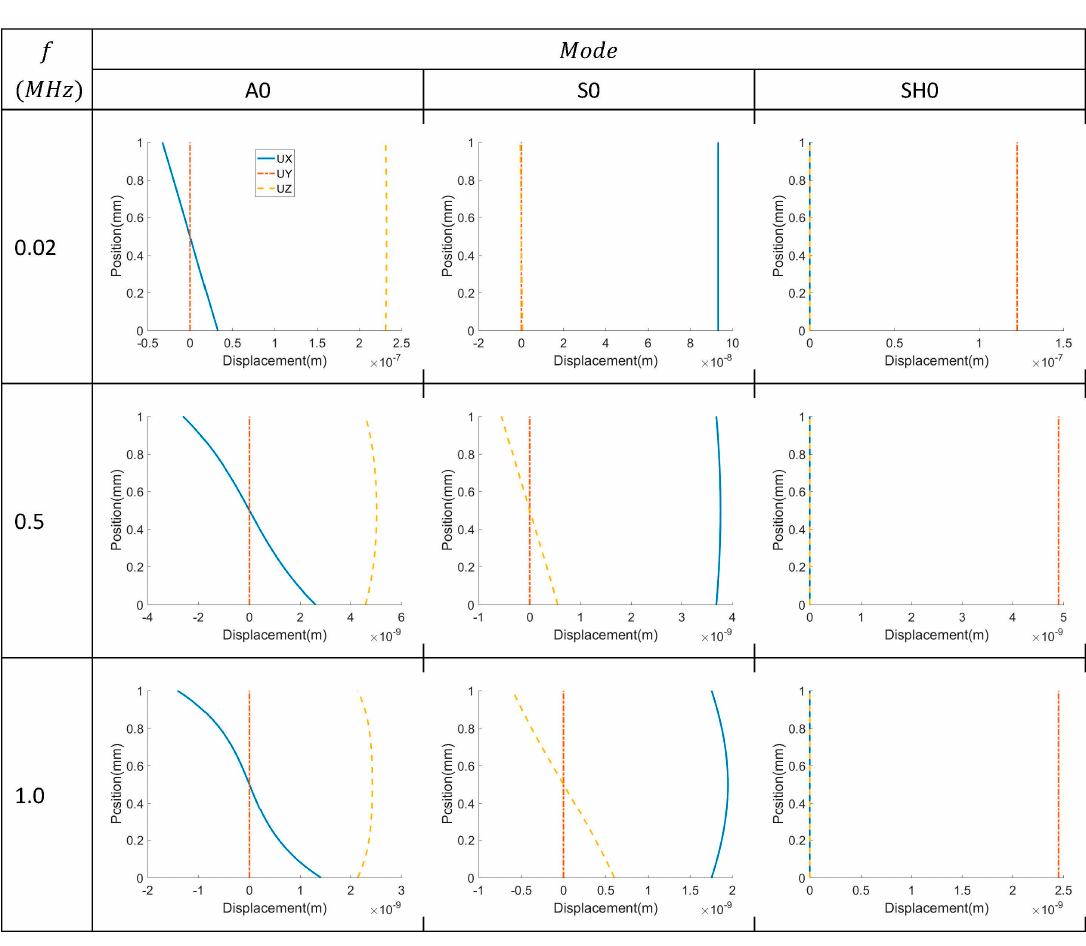
Figure 5. The displacement wave structures of A0, S0 and SH0 modes at 0.02, 0.5 and 1 MHz.